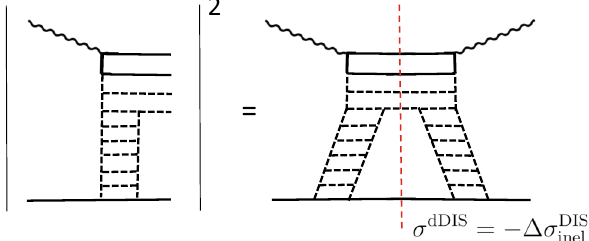
Fig. 3 A contribution to the cross section for diffractive DIS (dDIS). The left and right diagrams show | A | 2 and AA ∗